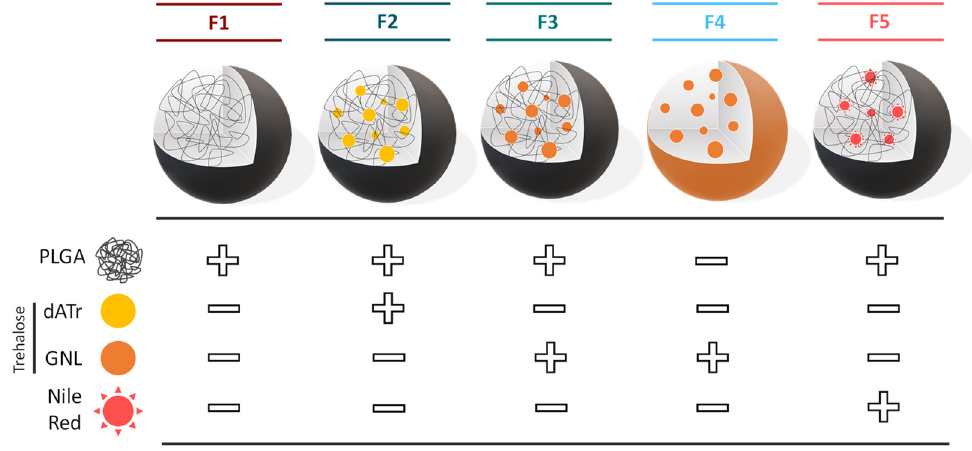
Figure 1. Schematic illustration of the nanoparticle compositions (+: presence of the compound; − : absence of the compound).